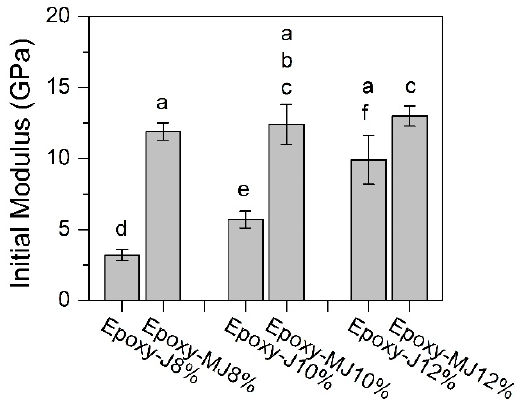
Figure 7. Initial modulus of the composite specimens.